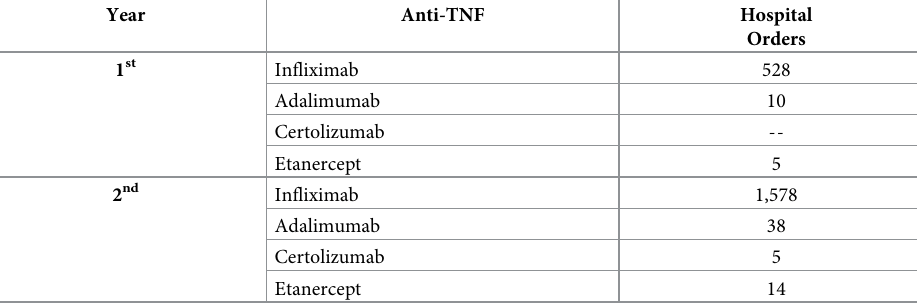
Table 1. DUR and Sales of Anti-TNFs during year 1 and year 2.